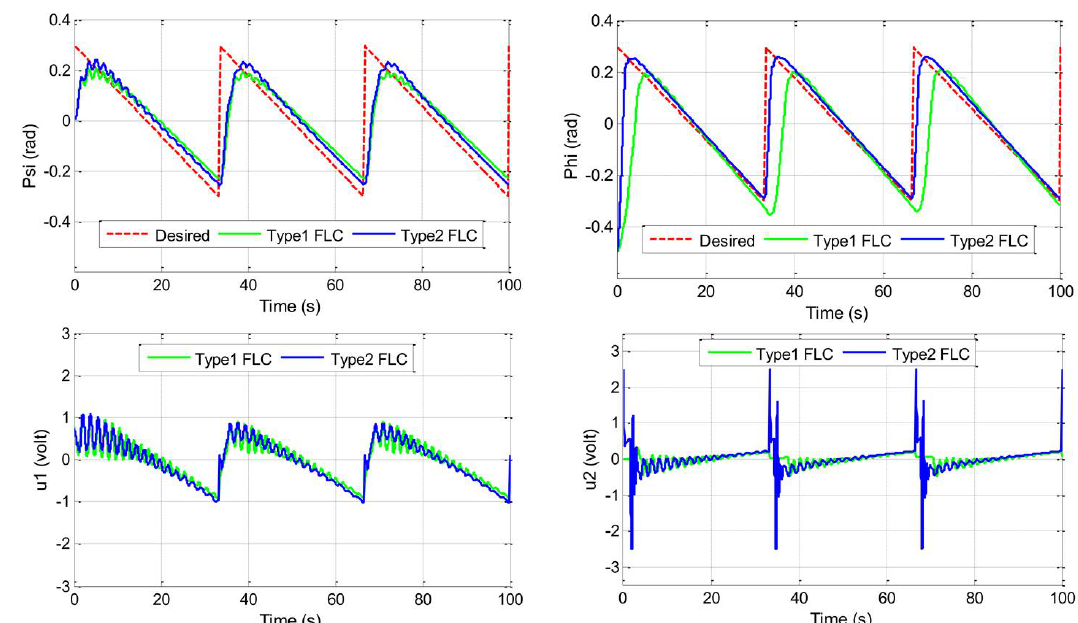
Figure 11. Triangular wave responses of the